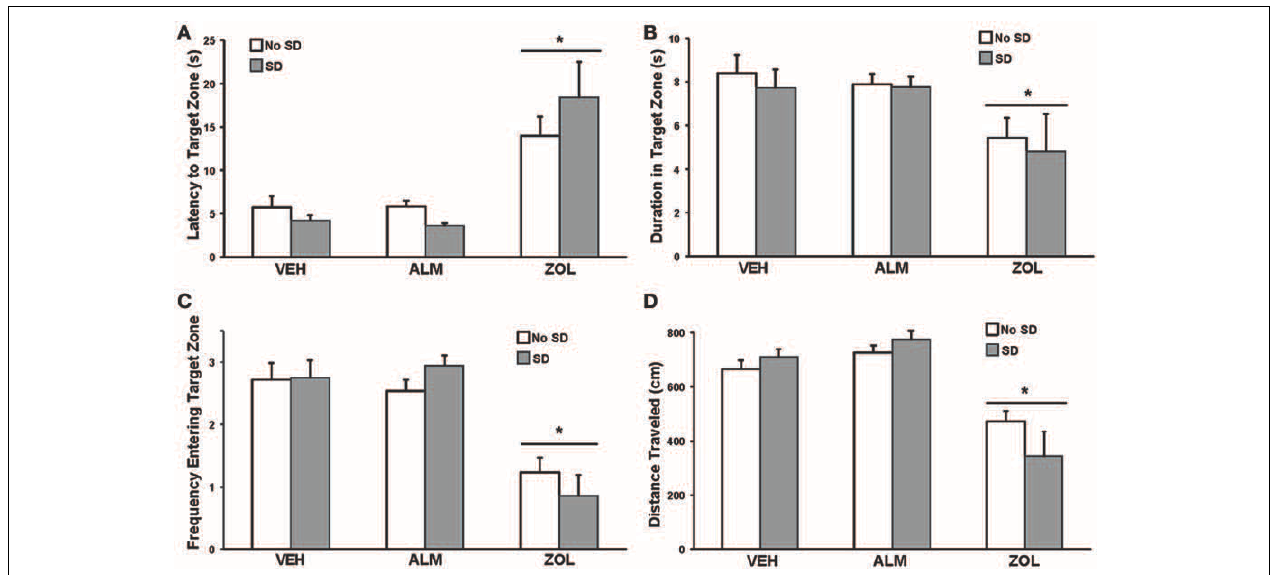
(A) Latency to the target zone. (B) Duration in the target zone. (C) Frequency entering the target zone. (D) Total distance traveled. For